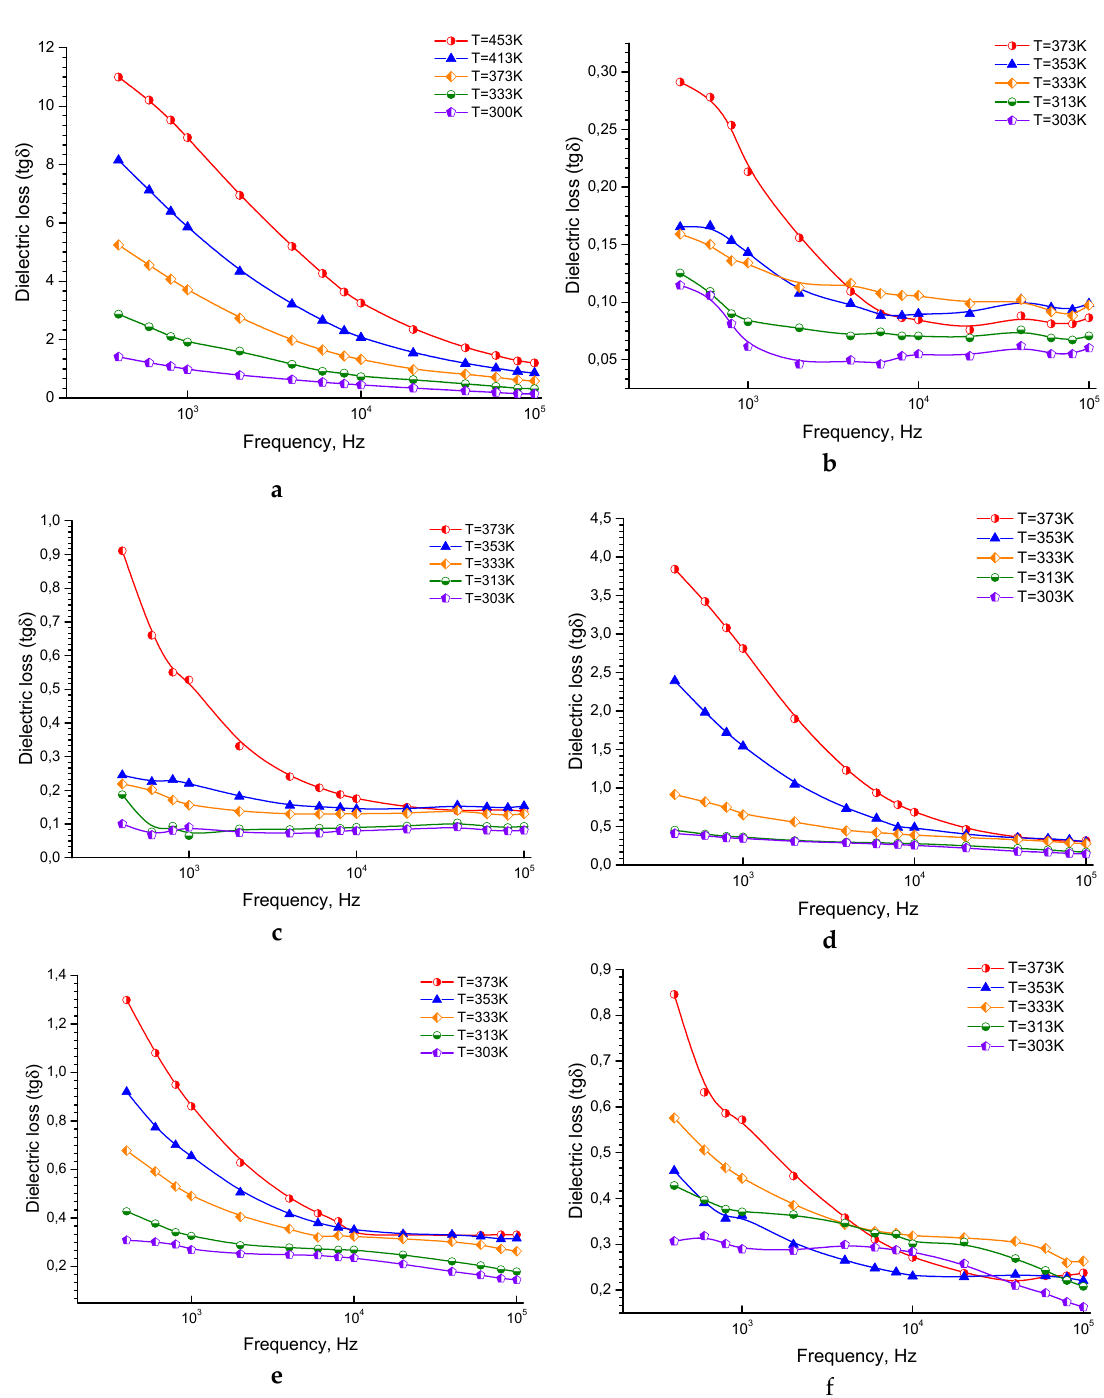
Figure 4. The tan δ dielectric loss as a function of the frequency of ferrite sintered at 1473K ( a ), pure epoxy ( b ), 20% ferrite + 80% epoxy ( c ), 30% ferrite + 70% epoxy ( d ), 40% ferrite + 60% epoxy ( e ), 50% ferrite + 50% epoxy ( f ).